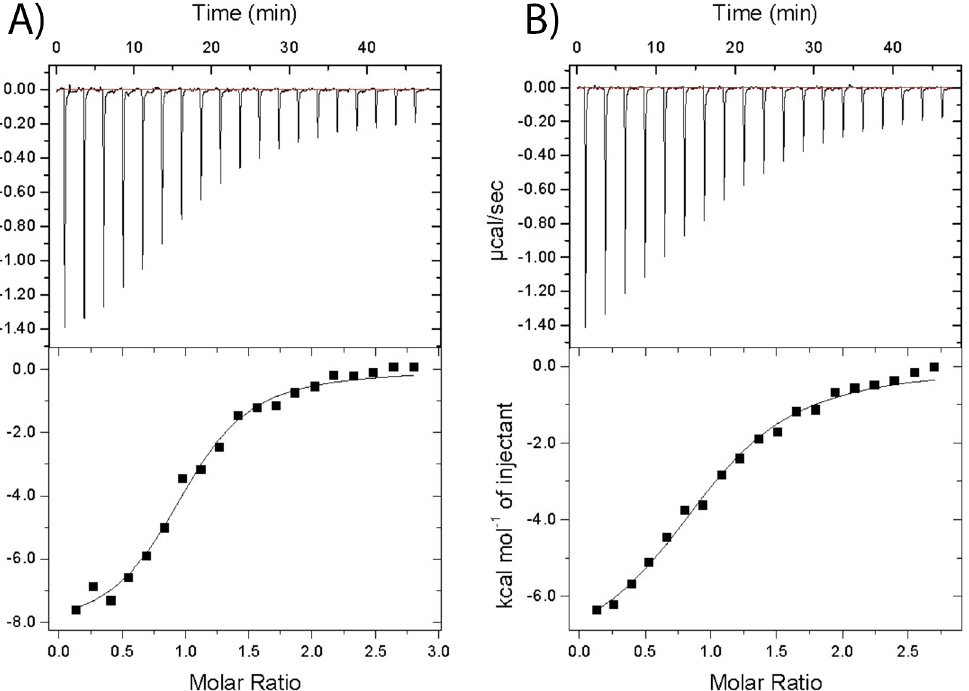
Fig 6. ITC experiments showing binding of A) ARTKme3QTAGKS and B) ARTKme3QTA to WT Sgf29. Thermodynamics of binding for A) K d = 4.0 ± 0.6 μ M, Δ G ° = - 7.4 ± 0.1 kcal mol -1 , Δ H ° = - 8.0 ± 0.1 kcal mol -1 ,-T Δ S ° = 0.6 ± 0.1 kcal mol -1 and for B) K d = 9.0 ± 0.5 μ M, Δ G ° = - 6.9 ± 0.1 kcal mol -1 , Δ H ° = - 7.8 ± 0.1 kcal mol -1 ,-T Δ S ° = 0.9 ± 0.1 kcal mol -1